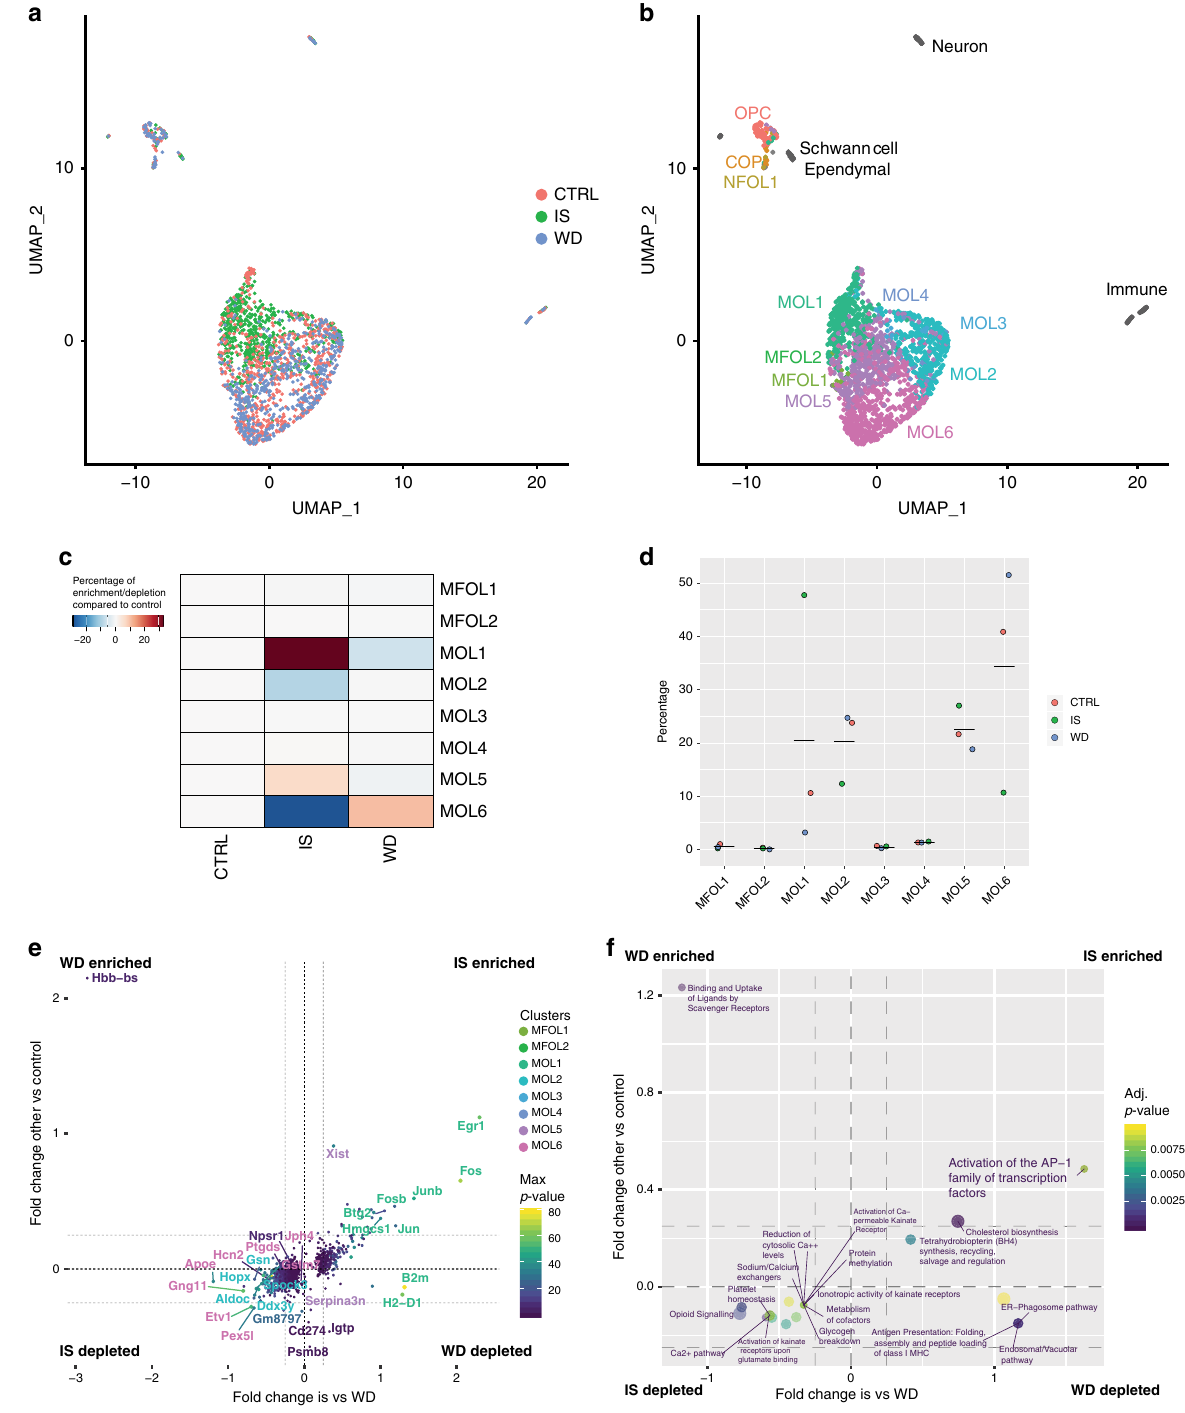
Fig. 6 MOL2 and MOL5/6 change their transcriptional pro fi le following traumatic spinal cord injury. a , b Uniform Manifold Approximation and Projection (UMAP) plots showing 1967 Sox10::Cre-GFP-positive cells from laminectomy control, injury site, and Wallerian degeneration regions contributing to the clusters ( a ) and cell lineage composition ( b ), as determined by graph-based clustering (Seurat) 27,28 and integration of labels with the Marques et al. scRNA-Seq dataset 5,17 . c , d Frequency distribution of the OL lineage cells from the laminectomy control and injury site ( c ) and Wallerian degeneration regions and injury site ( d ) forming the clusters. e , f 2D Volcano plots showing the differentially expressed genes ( e ) and biological processes ( f ) in the OL lineage cells from the injury site compared to laminectomy control and Wallerian degeneration regions. Gene symbols are colored according to the clusters that are enriched at, while the corresponding dot is colored according to the p value. The OL lineage was sorted from Sox10::Cre-GFP mouse line 3 months following spinal cord injury. CTRL laminectomy control, IS injury site, WD Wallerian degeneration. OPC oligodendrocyte progenitor cell, COP committed OPC, NFOL newly formed oligodendrocyte, MFOL myelin forming oligodendrocyte, MOL mature oligodendrocyte. Source data are provided as a Source Data fi